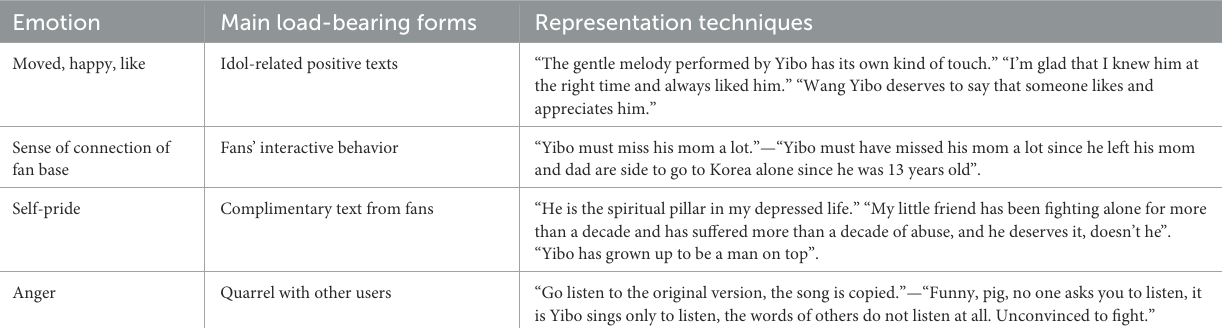
TABLE 1 Fan emotion category.